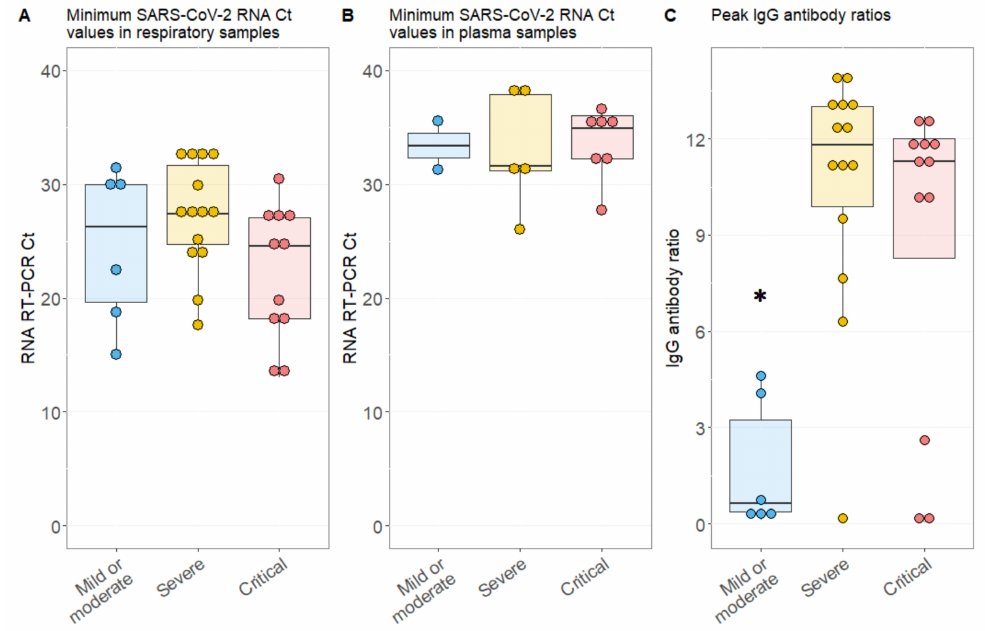
Figure 2. Molecular and serological parameters according to disease severity in COVID-19 patients. ( A ) Lowest detected SARS-CoV-2 RNA RT-PCR Ct value in respiratory samples per patient; ( B ) nadir SARS-CoV-2 RNA RT-PCR plasma Ct value per patient; ( C ) peak IgG value per patient; * p < 0.05; error bars, 95% confidence interval.